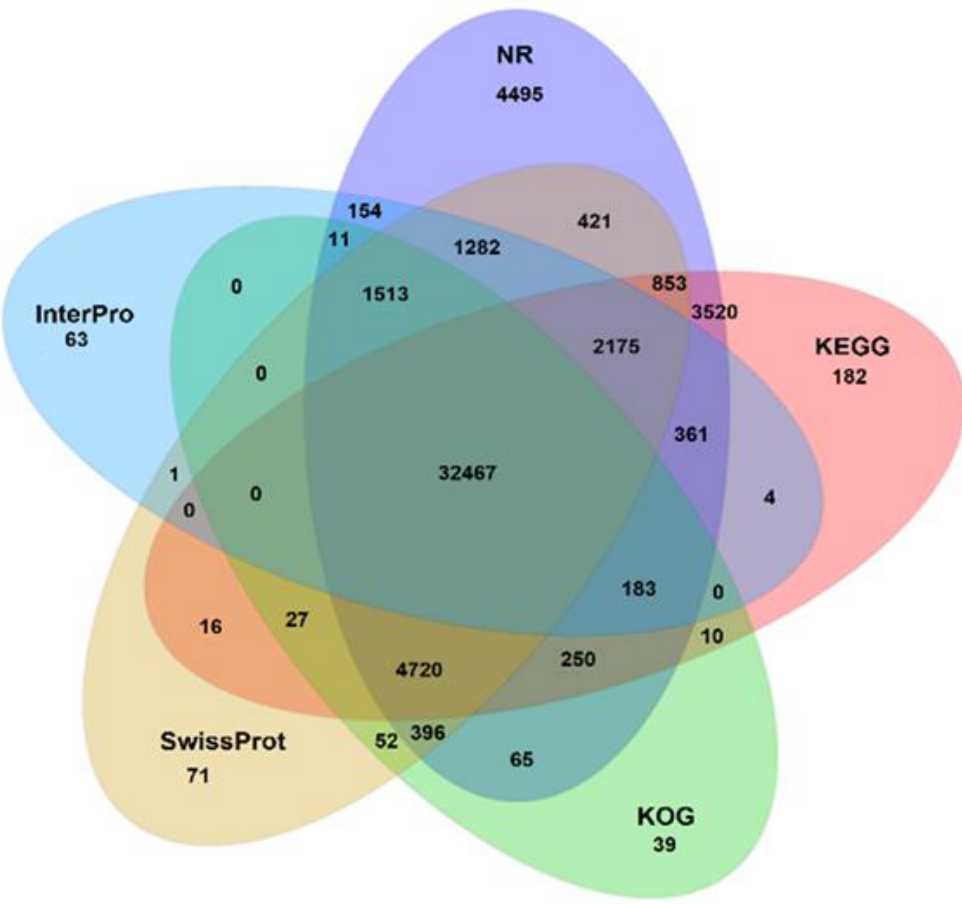
Figure 2. Venn diagram showing the genes of the loggerhead turtle, Caretta caretta , annotated to the databases Nr, KOG, KEGG, Swissprot, and Interpro.